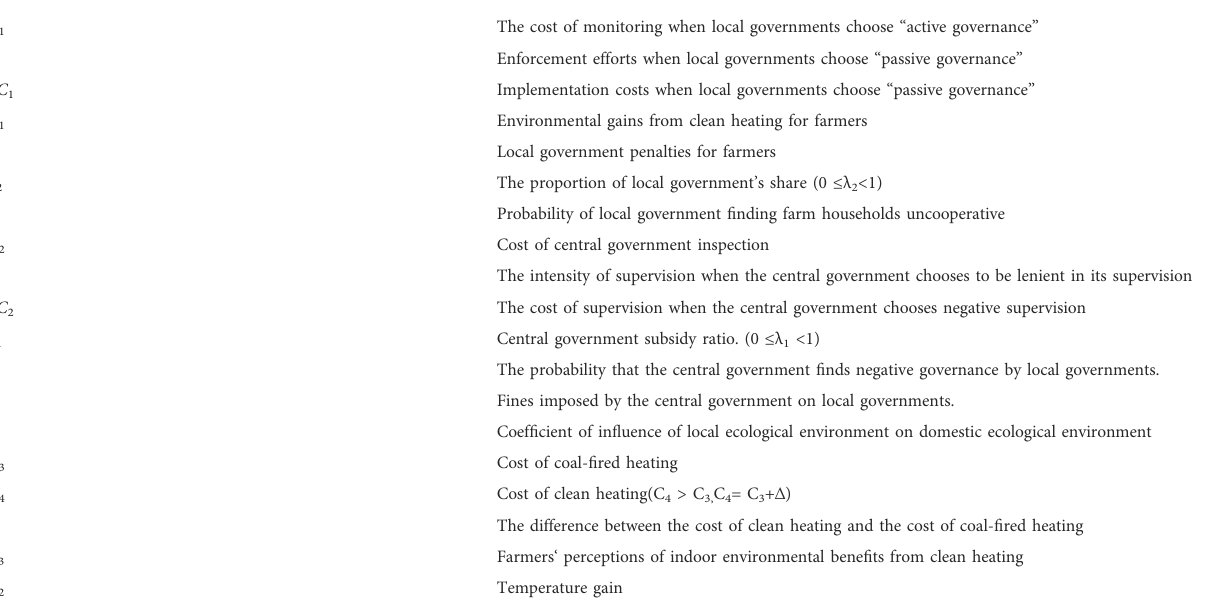
TABLE 1 Meaning of